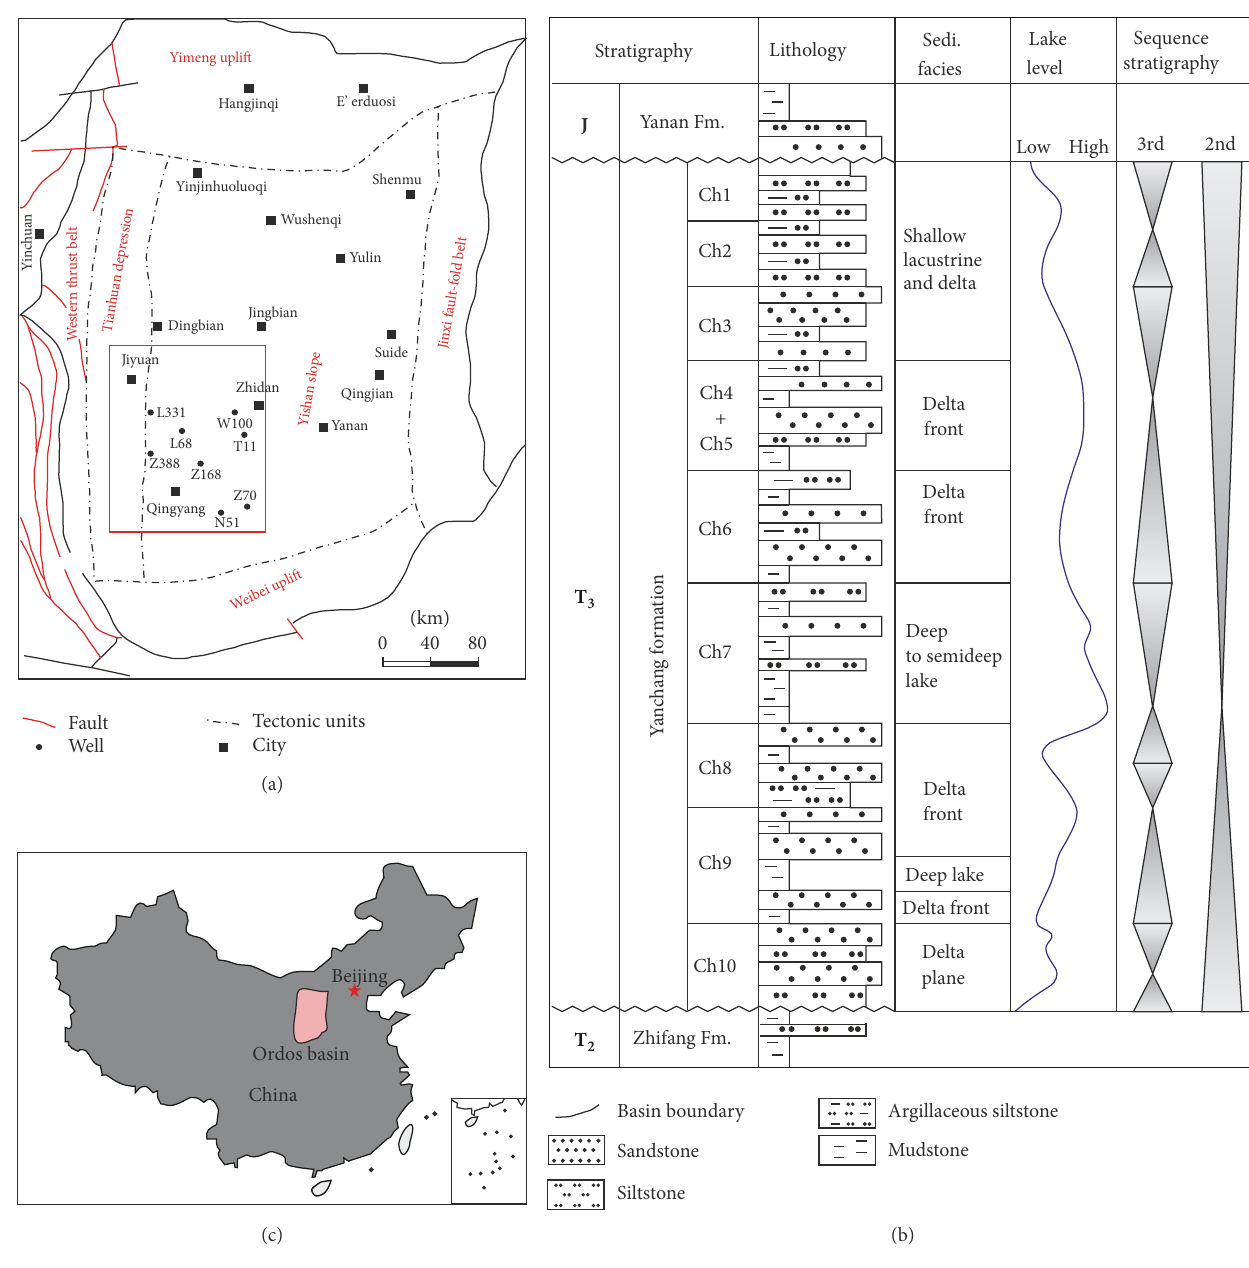
Figure 1: (a) The tectonic divisions of Ordos basin (after [6, 18, 24, 25]); (b) sequence stratigraphic column of Upper Triassic Yanchang Formation in Ordos basin, Ch = Chang (after [4]); and (c) map showing the location of the Ordos basin within